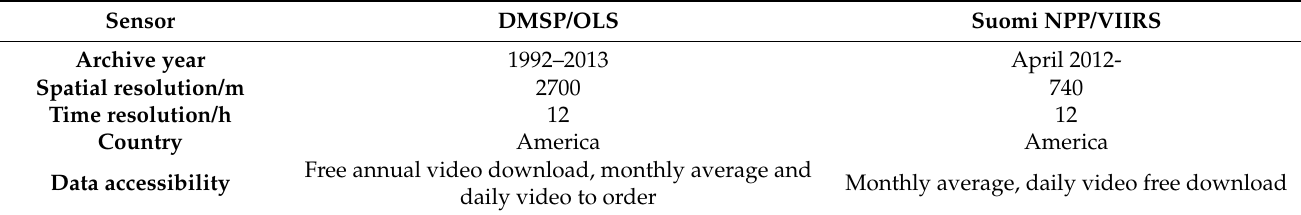
Table 1. The basic parameters of DMSP/OLS and NPP/VIIRS.